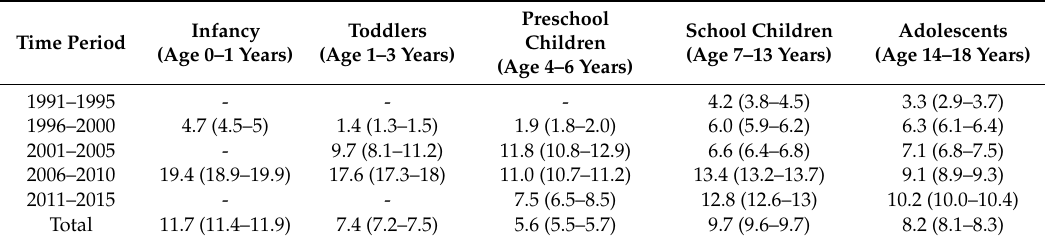
Table 2. Subgroup analysis by development stage of the prevalence of overweight in Chinese children and adolescents aged 0–18 years